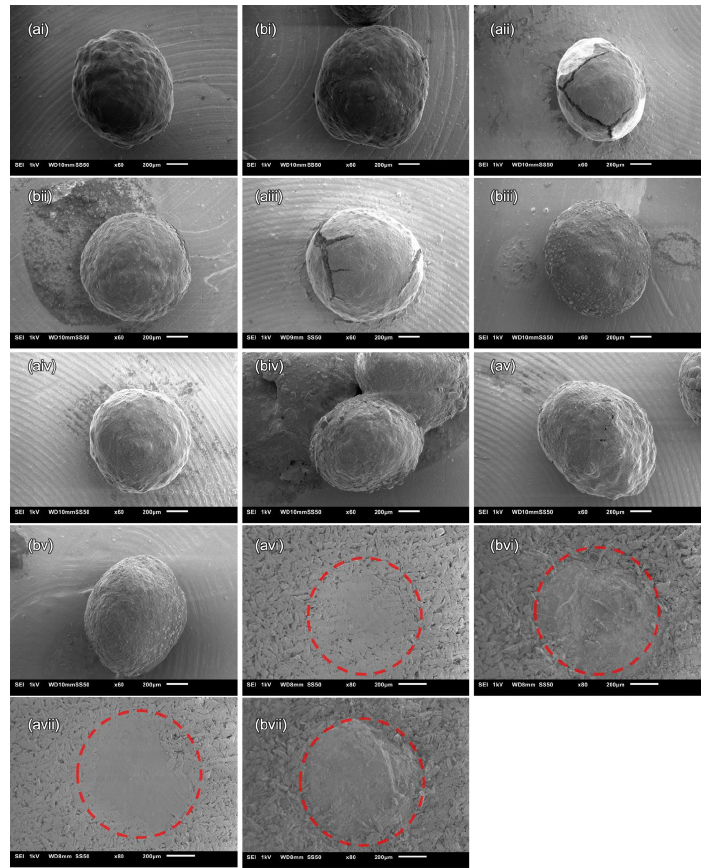
Figure 1. SEM images of ( a ) MCC and ( b ) XPVP pellets that were ( i ) uncompacted or compacted at ( ii ) 10, ( iii ) 20, ( iv ) 30, and ( v ) 40 MPa. Pellets still embedded in the surface of the MUPS tablet compacted at ( vi ) 30 and ( vii ) 40 MPa are encircled by a red dashed line.